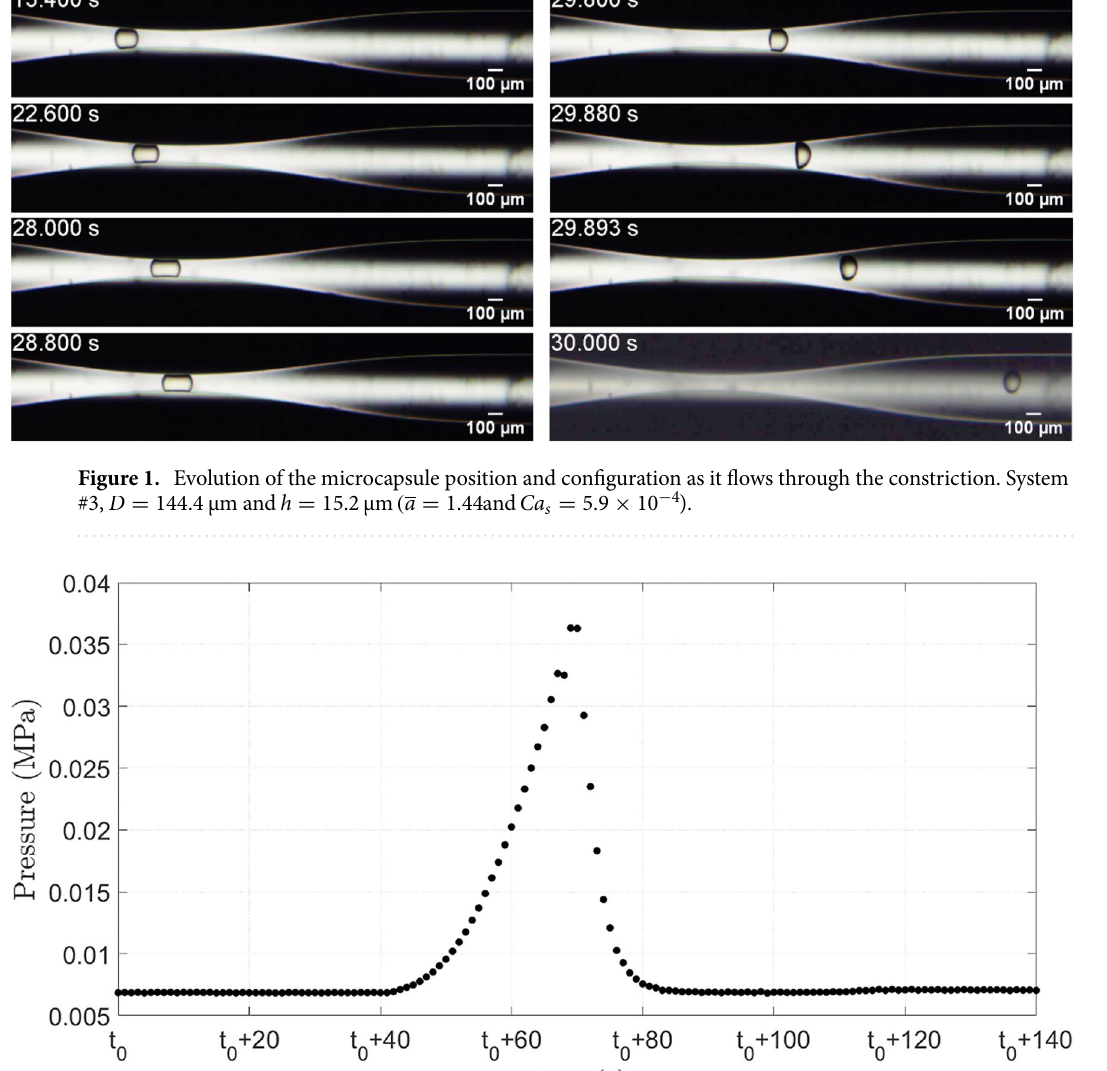
Figure 2. Evolution of the inlet pressure as the capsule flows through the constriction. System #3, D = 144.4 − 4 μm and h = 15.2 μm ( a = 1.44 and Ca s = 5.9 × 10